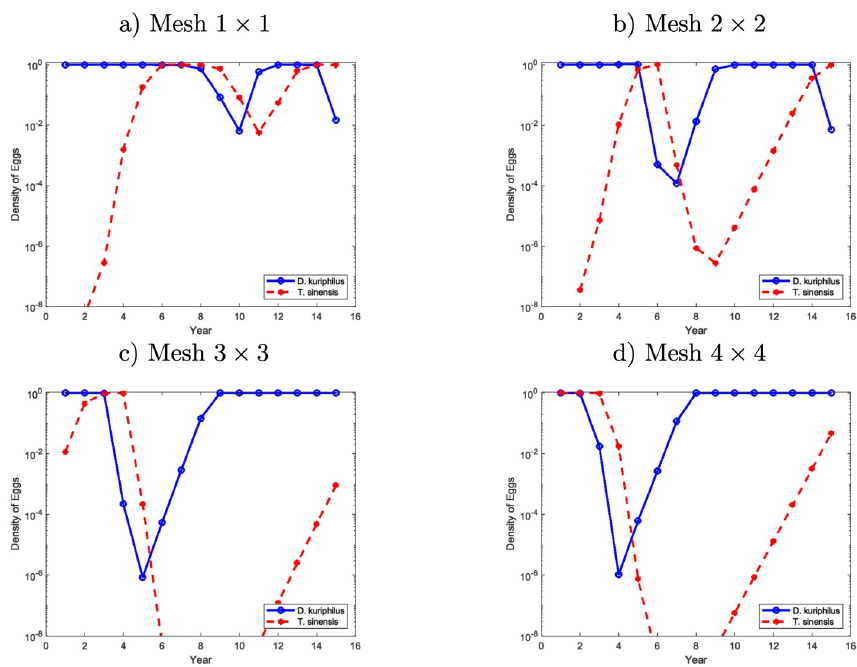
) and T . sinensis ( q ) in a given place of the forest over the time. n n